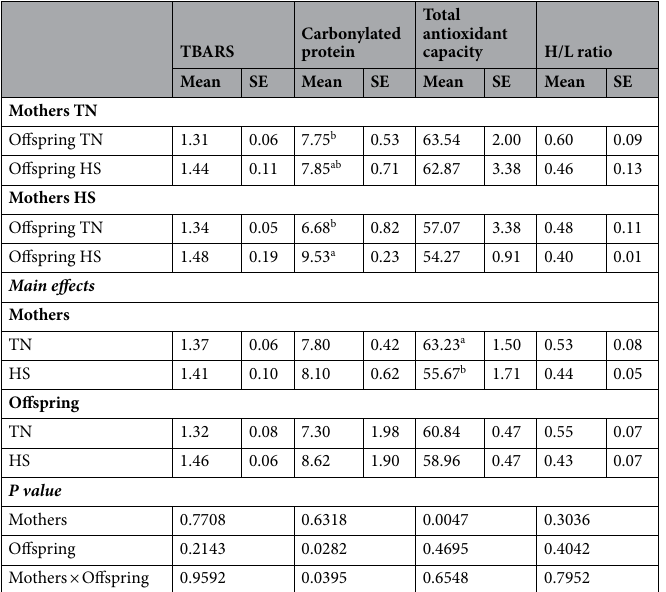
Table 4. Oxidative parameters and H/L ratio of Japanese quail ( Coturnix coturnix japonica ) chicks raised under thermoneutral or heat stress conditions ( n = 6). Results are presented as mean and standard error (SE). TBARS lipid peroxidation, H/L ratio heterophil/lymphocyte ratio, TN thermoneutral, HS heat stress. a,b Different superscript letters in the same column indicate a significant difference by Tukey’s test and the t test ( P <